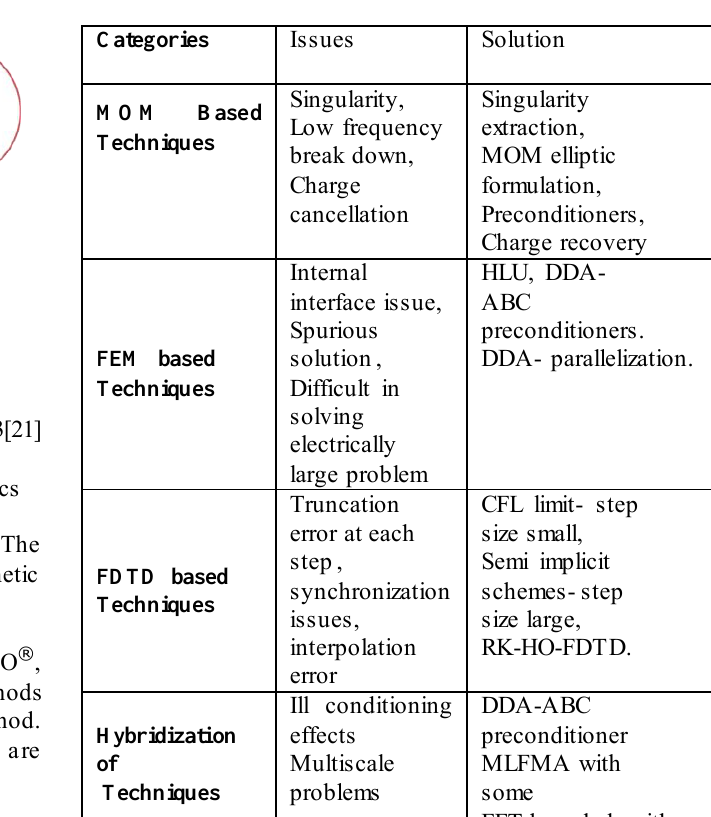
Table 1: Survey on CEM